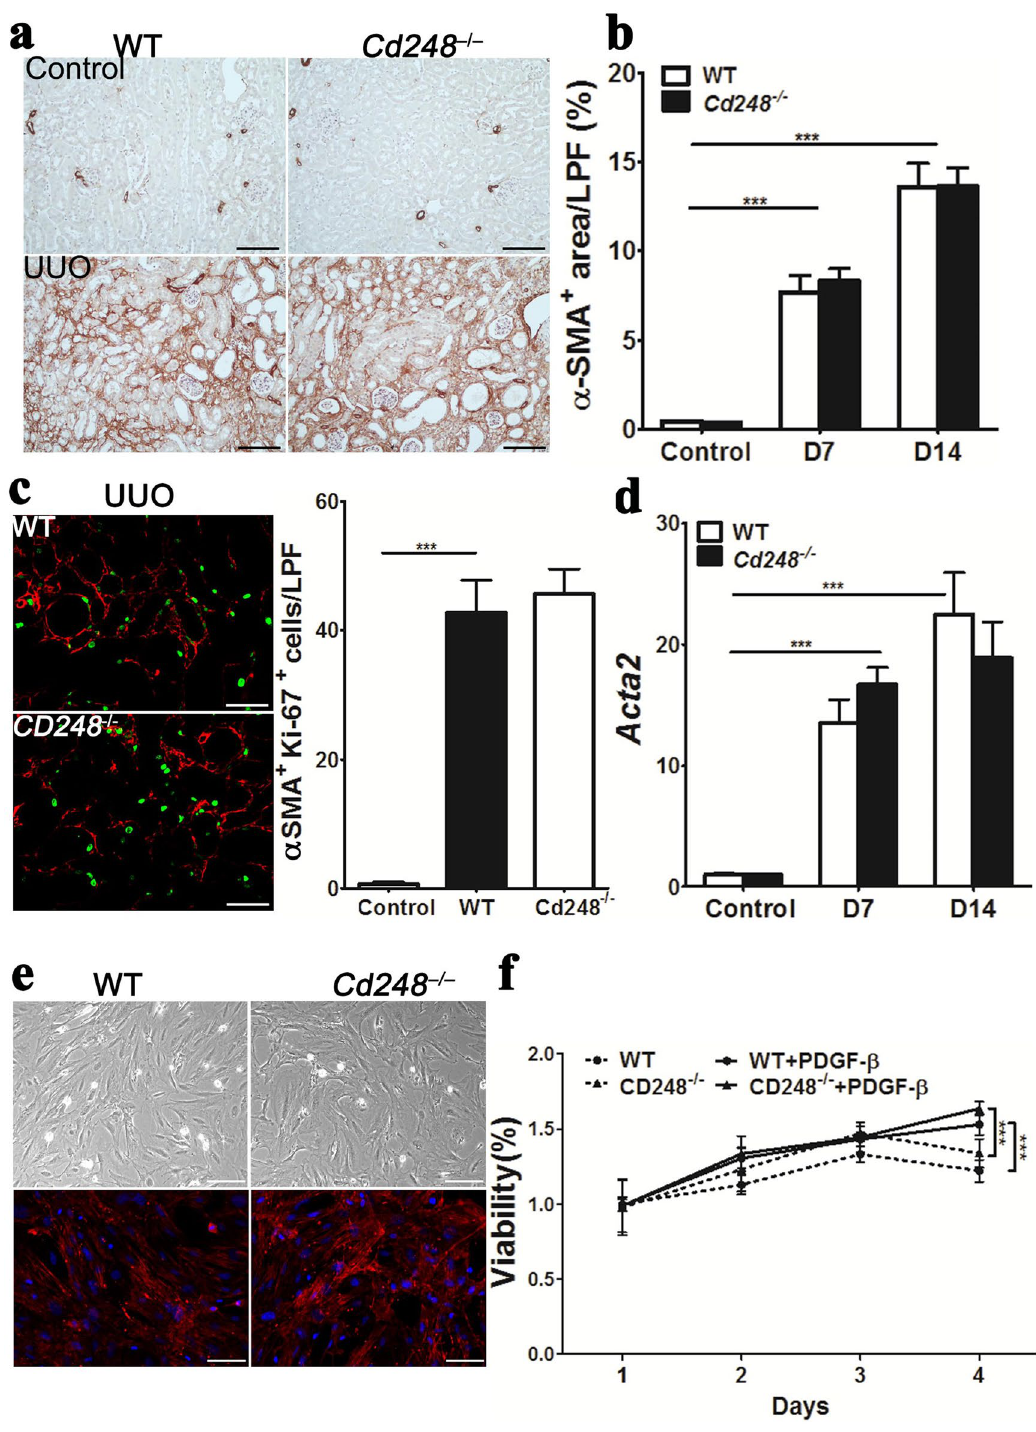
Figure 2. Cd248 disruption did not affect proliferation of kidney myofibroblasts. ( a ) Representative images of α-smooth muscle actin (αSMA) immunostaining for myofibroblasts in control and D14 UUO kidneys. αSMA + staining was brown. Original magnification, × 100. Scale bar, 100 μm. ( b ) Quantification of αSMA + areas on LPF images of kidney sections taken at 100× magnification. n = 6. ( c ) Representative images of immunostaining for αSMA (red) and Ki67 (green) in D7 UUO kidneys. Original magnification, × 100. Scale bar, 100 μm. Bar chart showing the number of αSMA + Ki67 + cells/LPF. n = 6. ( d ) qPCR of renal Acta2 , which encoded αSMA. n = 6. ( e ) Representative images for bright-field (upper panel) and αSMA (lower panel) staining of cultured myofibroblasts isolated from D7 UUO kidneys. Original magnification, × 100. Scale bar, 100 μm. ( f ) Platelet-derived growth factor-B stimulated proliferation of cultured myofibroblasts, as determined by 3-(4, 5-dimethylthiazolyl-2)-2, 5-diphenyltetrazolium bromide assay. The y axis shows the optic density (OD550) relative to day 0. n = 5. Data were expressed as means ± standard errors of the mean. *** P < 0.001 by one-way ANOVA with post hoc Tukey’s multiple comparisons